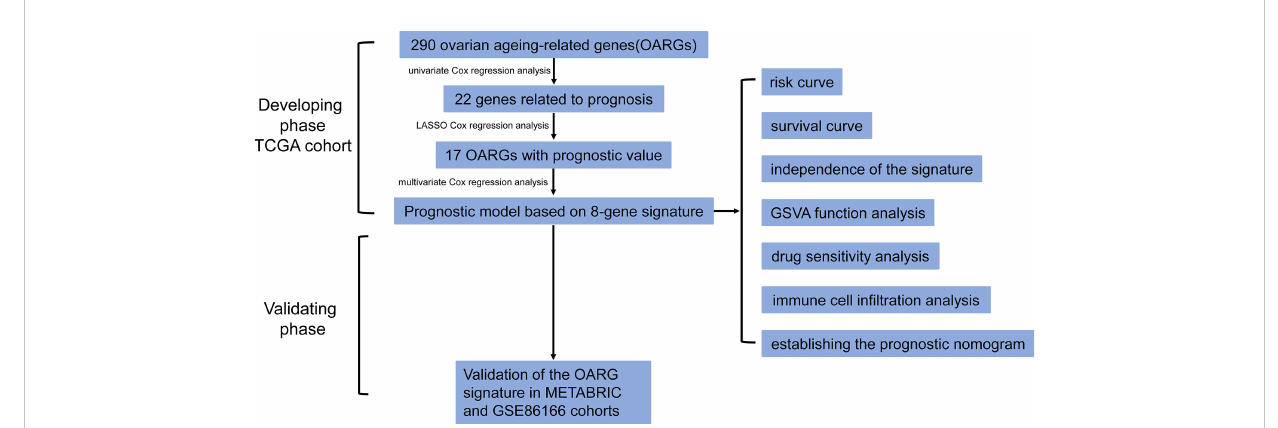
FIGURE 1 The fl ow chart detailing the comprehensive analysis of ovarian aging patterns in postoperative breast cancer